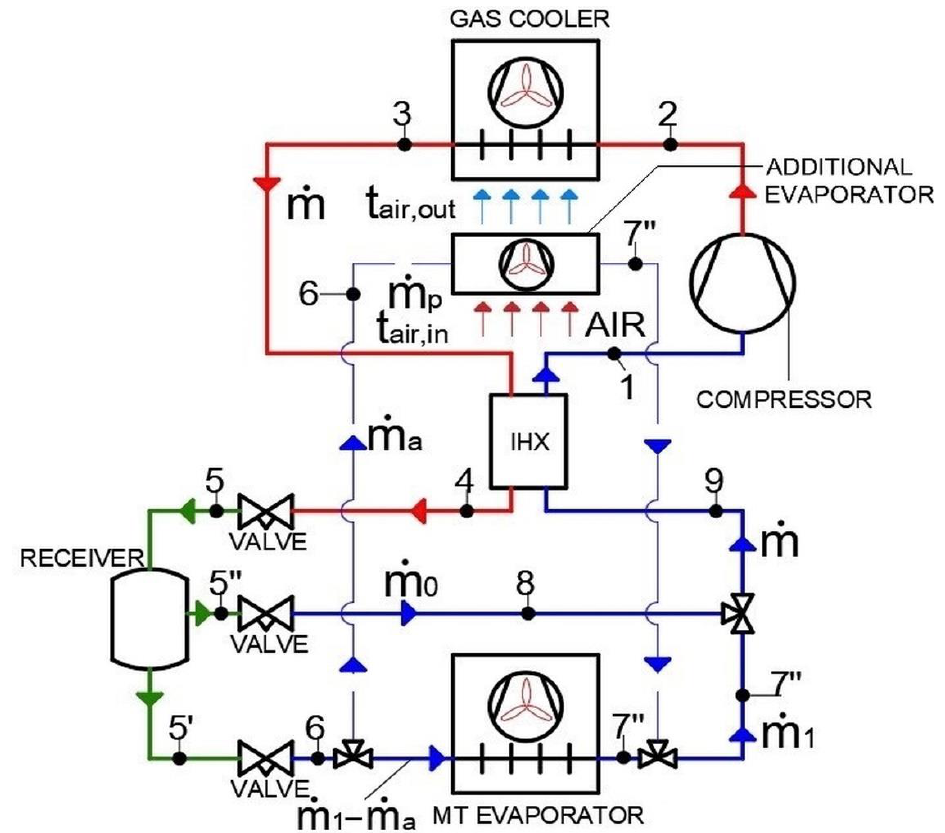
. Figure 3. The refrigeration system with the additional evaporator (air cooler). ṁ —total refrigerant Figure 3. The refrigeration system with the additional evaporator (air cooler). m—total refrigerant . mass flow rate, (kg/s); ṁ a —refrigerant mass flow rate through the additional evaporator, (kg/s); mass flow rate, (kg/s); m a —refrigerant mass flow rate through the additional evaporator, (kg/s); . . ṁ 0 —dry vapor refrigerant mass flow rate, (kg/s); ṁ 1 —refrigerant mass flow rate through the evap- m 0 —dry vapor refrigerant mass flow rate, (kg/s); m 1 —refrigerant mass flow rate through orator, (kg/s).